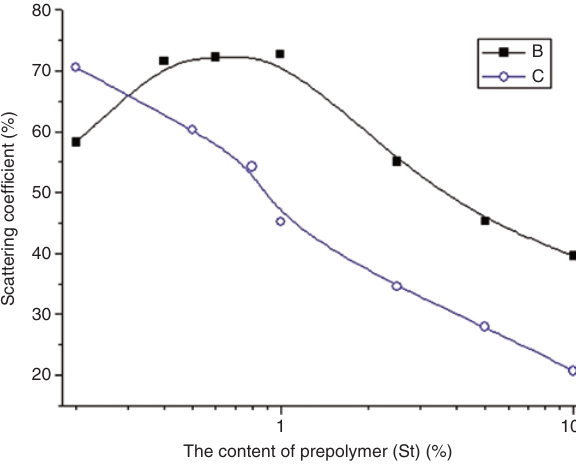
Figure 5: The effect of α -hydroxylethyl ferrocene concentration on the light scattering coefficient. Curve B – sample without adding α -hydroxylethyl ferrocene, curve C – sample adding α -hydroxylethyl ferrocene.